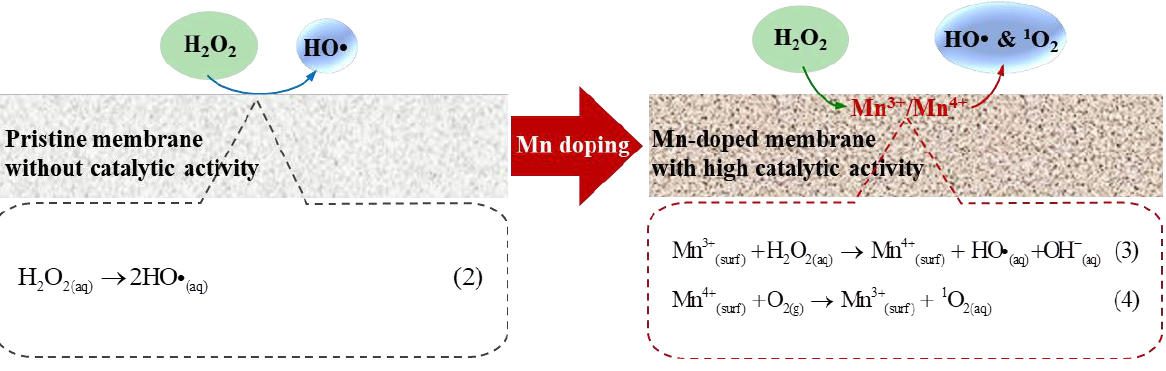
Figure 7. Schematic diagram of H 2 O 2 decomposition catalyzed by the pristine membrane and Mn-doped membrane.